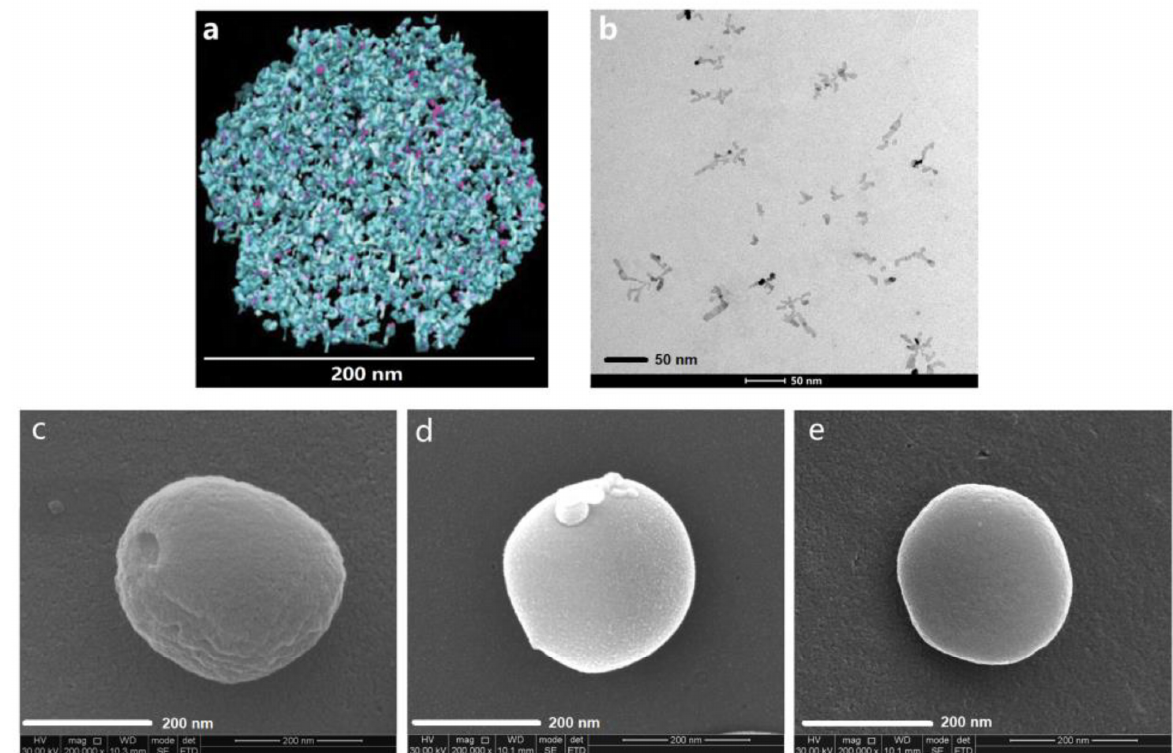
Figure 15. Modification of the casein-nanoparticles through phosphatidylcholine. ( a ) The image of the casein-nanoparticle derived from cryo-transmission electron tomography comes from the literature [151], with permission from Elsevier, 2011; ( b ) TEM image of phosphatidylcholine (PC); ( c ) SEM image of casein-nanoparticles; ( d ) SEM image of PC–casein nanoparticles, ( e ) SEM image of Cx-PC–casein